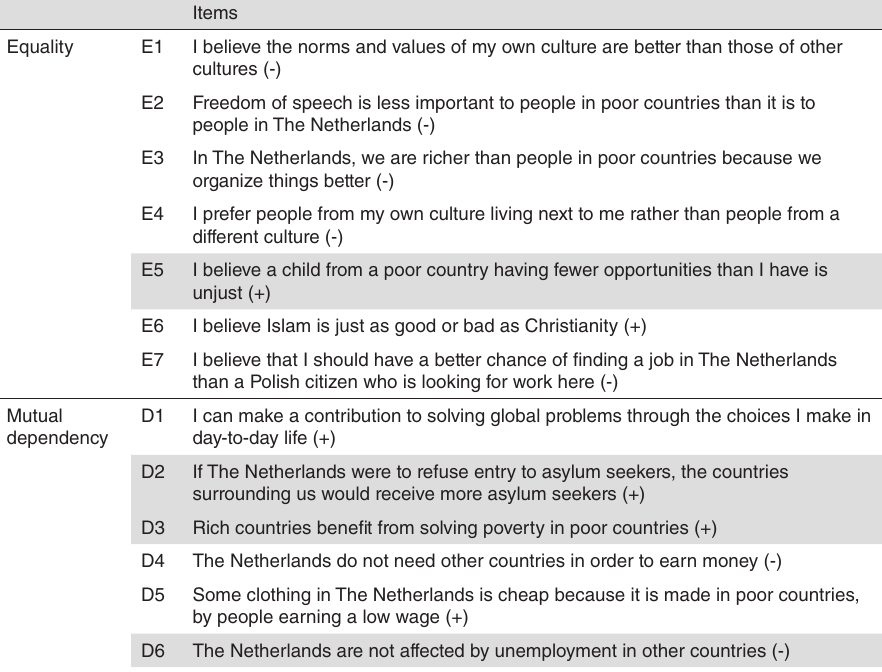
Table 2: Empirical properties of principles underlying global citizenship Items